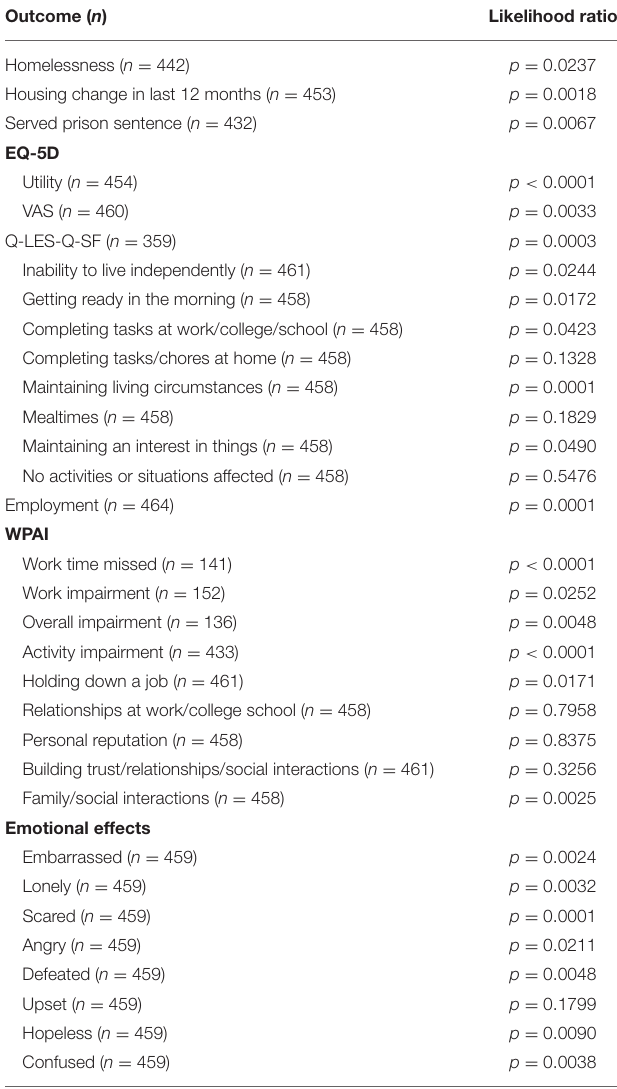
TABLE 2 | Association of number of relapses and psychosocial outcomes. Outcome ( n ) Likelihood